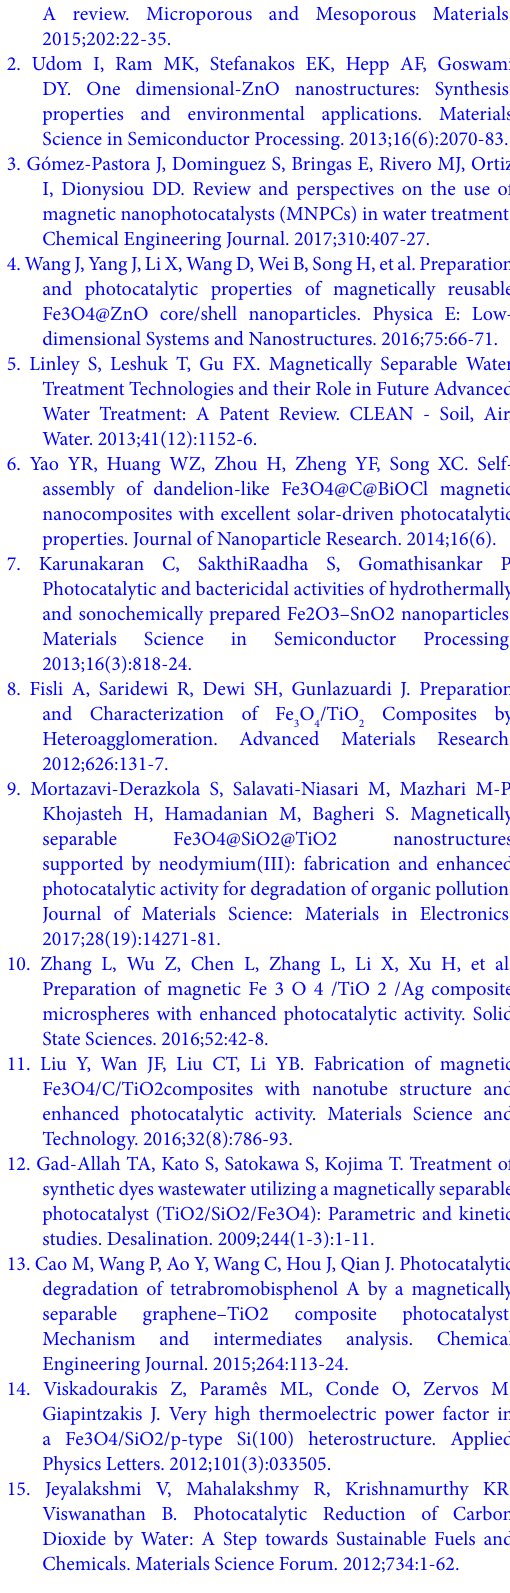
Fig. 20. a- Sewage containing TiO b- Sewage containing TiO